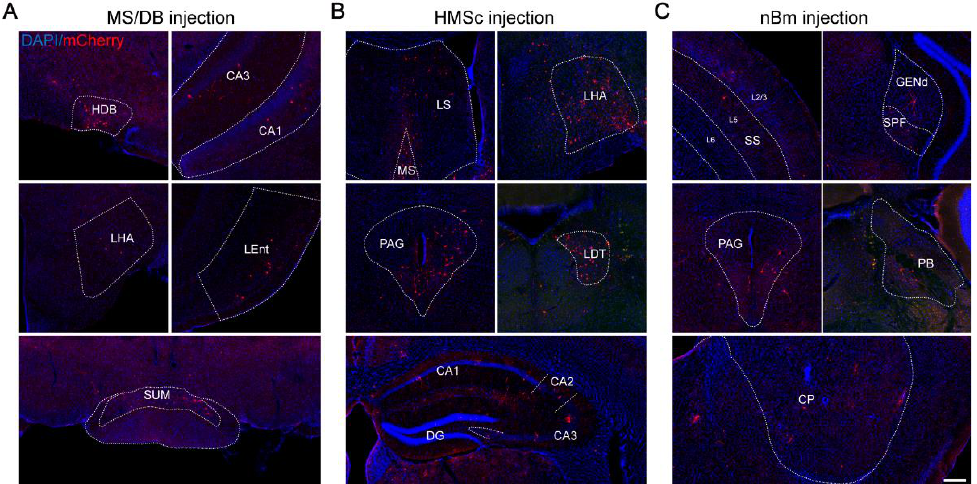
Figure 2. Outputs of the ChAT + cells in different subregions of the BF. ( A – C ) Representative brain regions were labeled by anterograde monosynaptic virus injected into three subregions: MS/DB ( A ), HMSc ( B ), and nBm ( C ). Scale bar, 100 μm. DAPI (blue) for the nucleus, HSV (mCherry) for the output neurons.